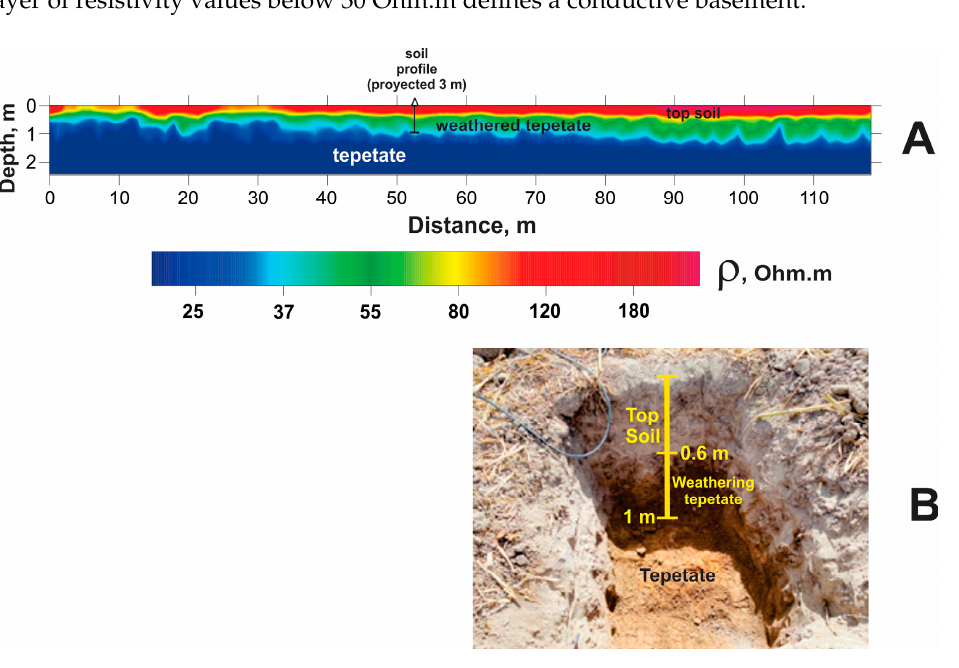
Figure 4. ( A ) Resistivity section from ERT-EMP procedure obtained in the plot used for sweet sorghum crops. ( B ) Soil profile observed near to profile ERT-EMP.